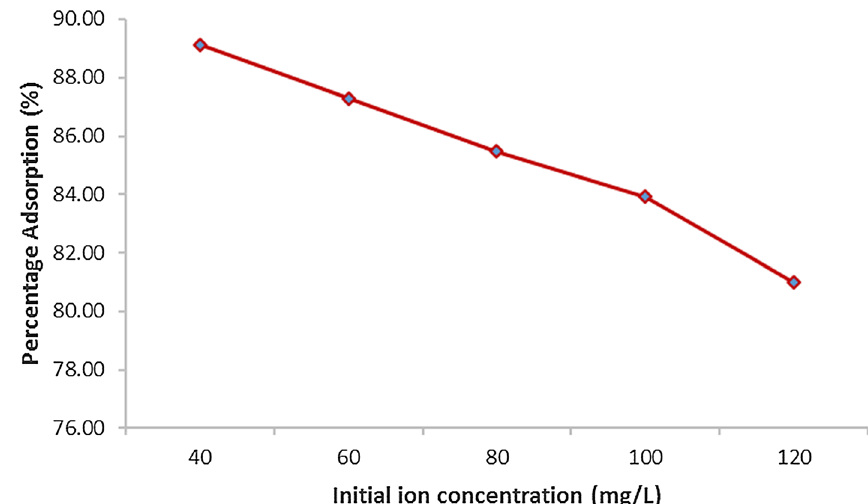
Fig.4 Influence of initial cya- nide concentration of cyanide adsorption from cassava waste- water onto